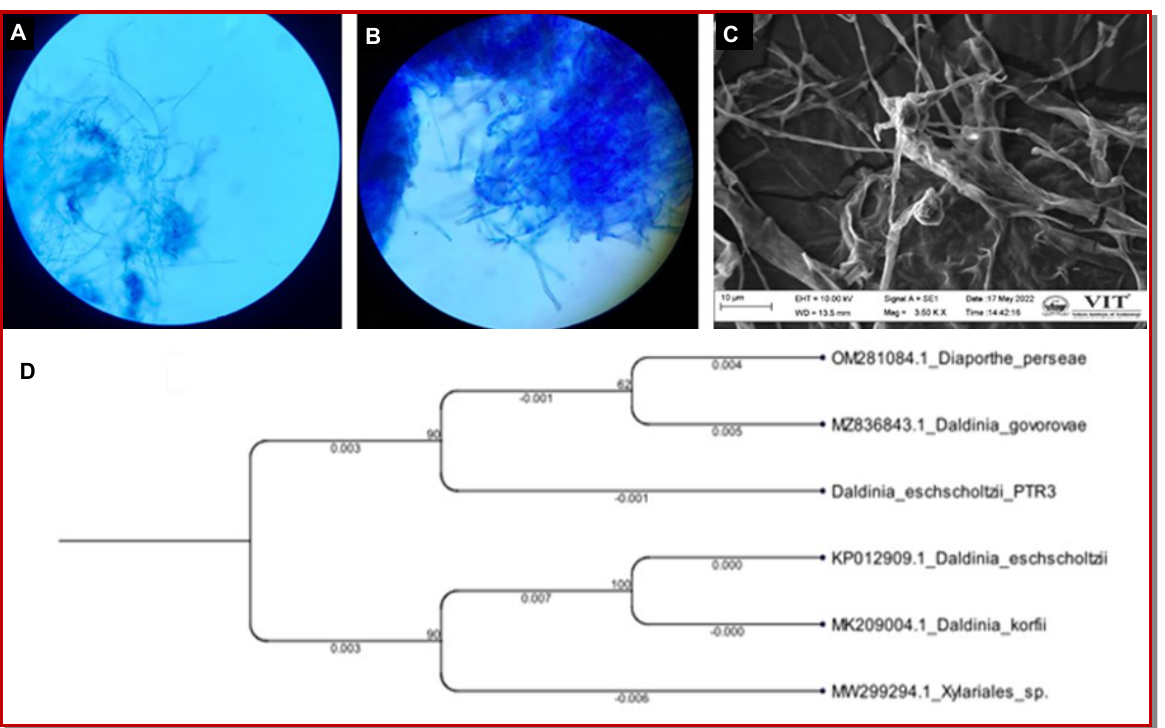
Figure 2: LCB stained at 40x (A) and 100x (B), SEM (C), Phylogenetic tree (D) generated by maximum likelihood of Daldinia esch- scholtzii PTR3